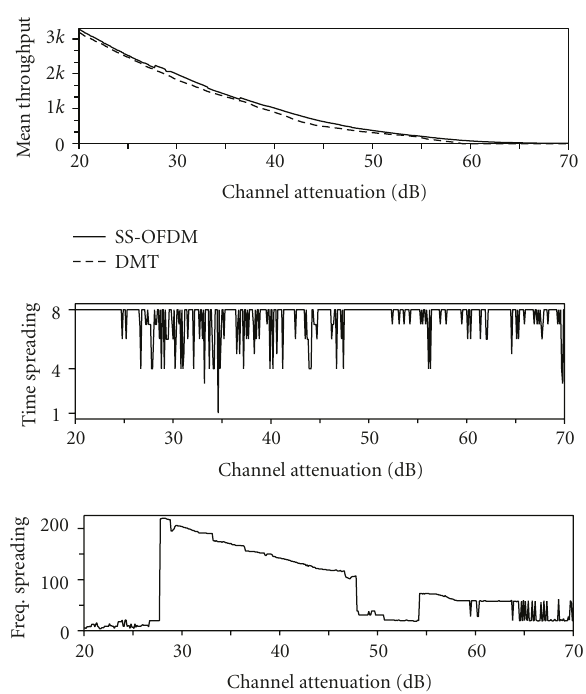
Figure 11: Throughput of DMT and SS-OFDM maximal reli- able upper-bound in bit per OFDM symbol, relative through- put R/ ( L t R ) of SS-OFDM systems in percent versus channel attenua- tion in dB, with configurations { L t , L f } ∈ {{ 4,94 } ; { 6,40 } ; { 8,2 } ; { 1,1 }} .